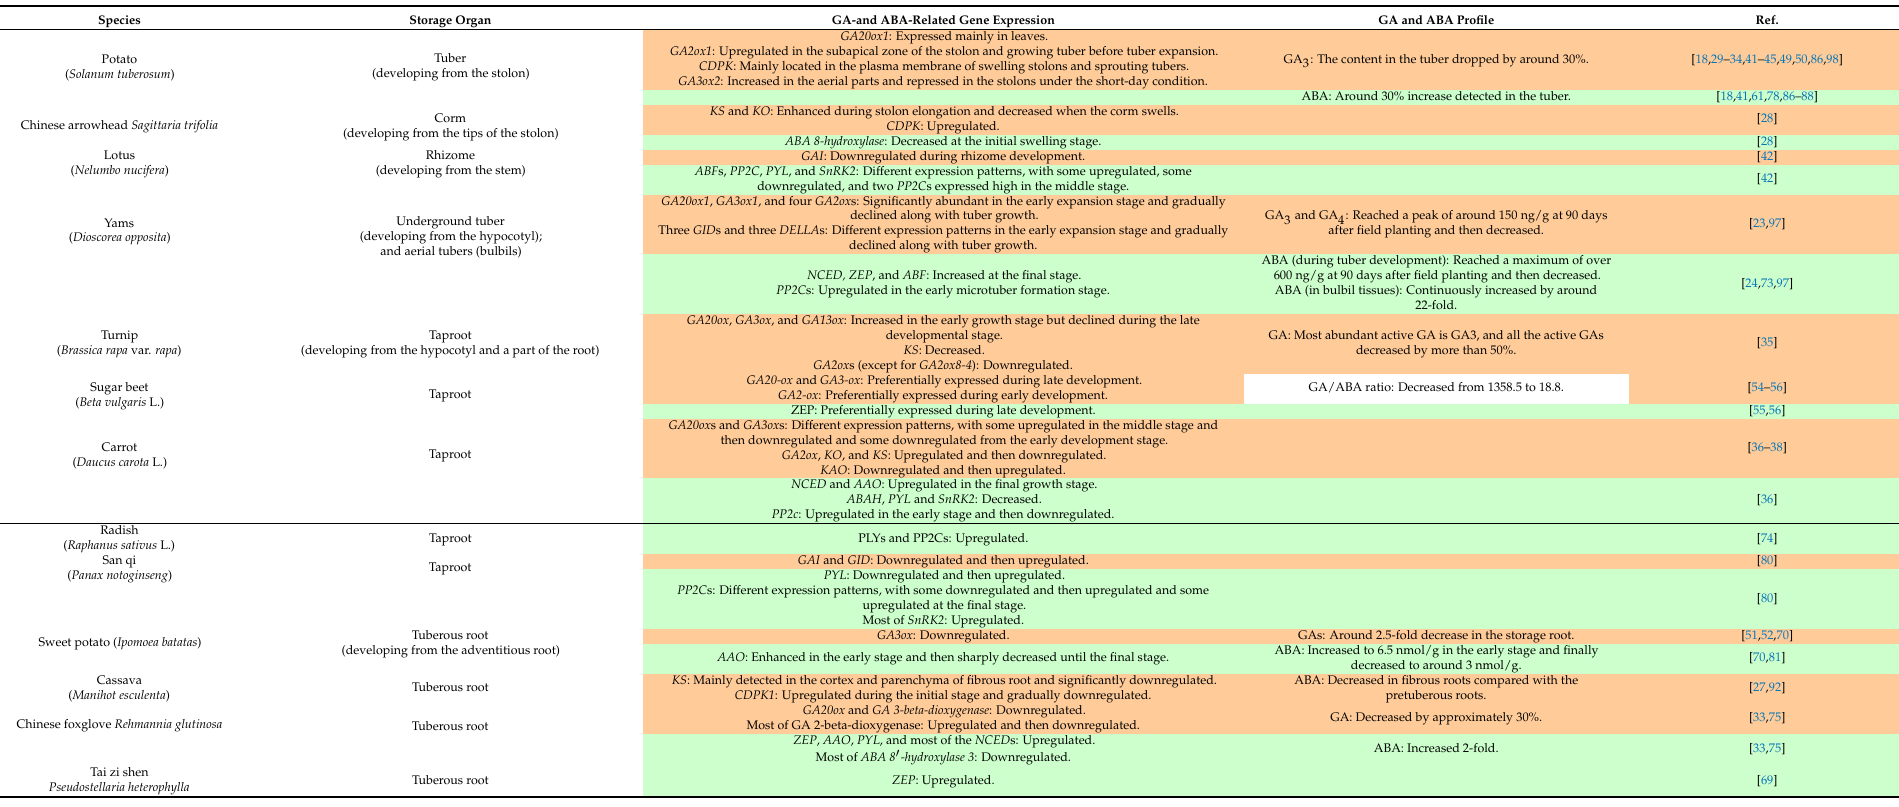
Table 1. The GA-and ABA-related gene expression patterns and GA and ABA profiles during stem/root tuber development in different tuber and root crops described in the